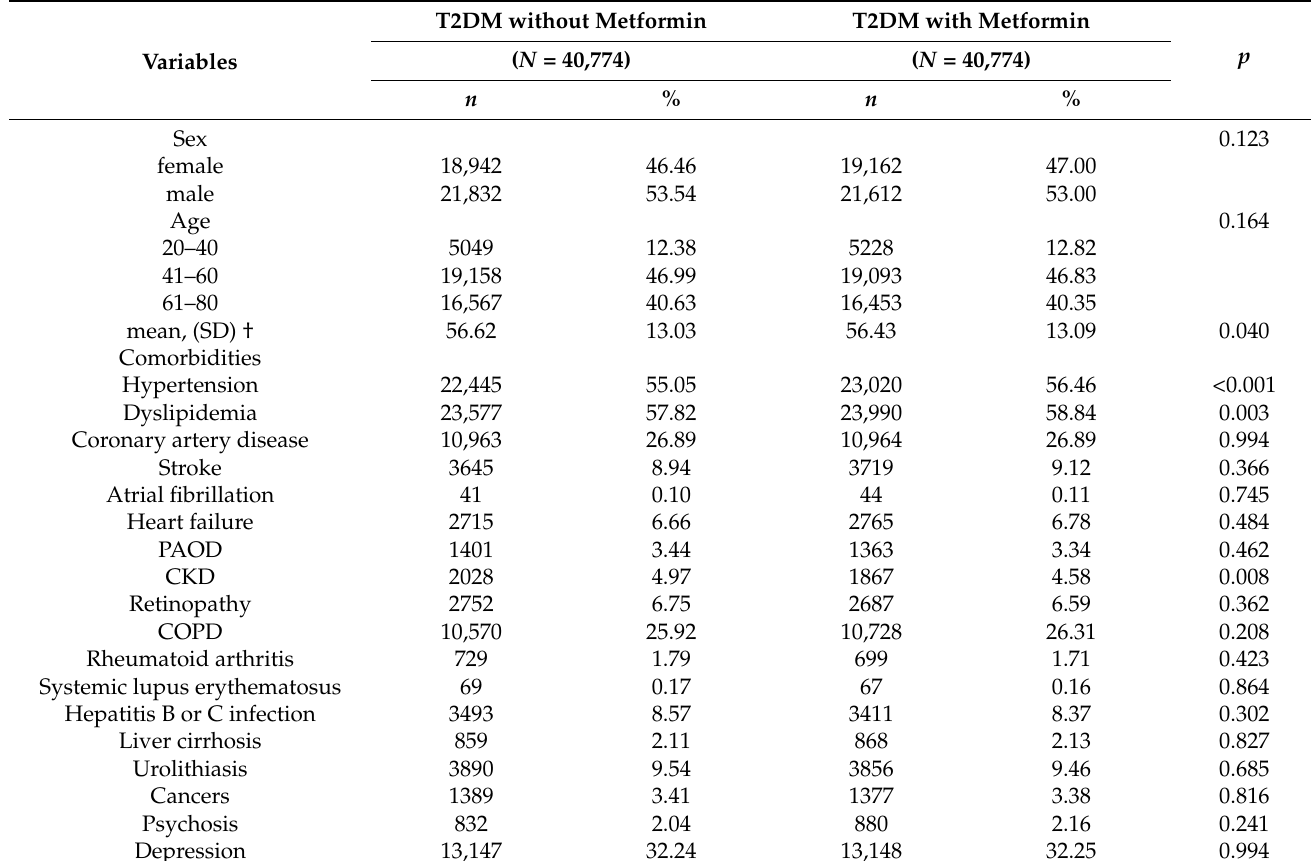
Table 1. Comparison of baseline characteristics in T2DM cohorts with and without metformin